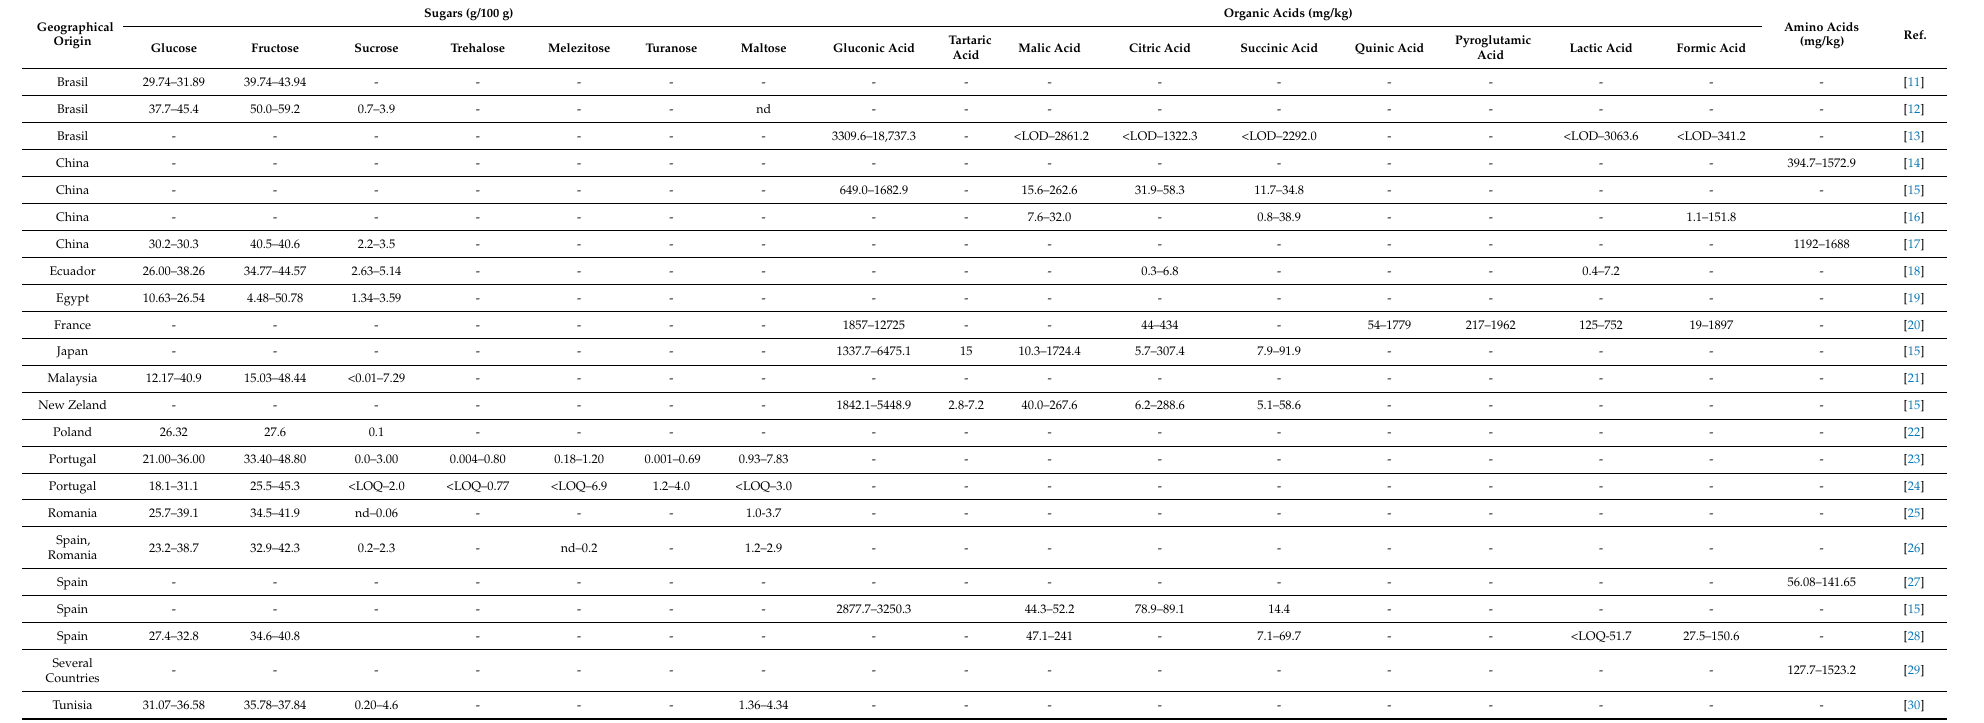
Table 1. Sugar (g/100 g), organic acid (mg/kg) and amino acid (mg/kg) contents of honey from different geographical